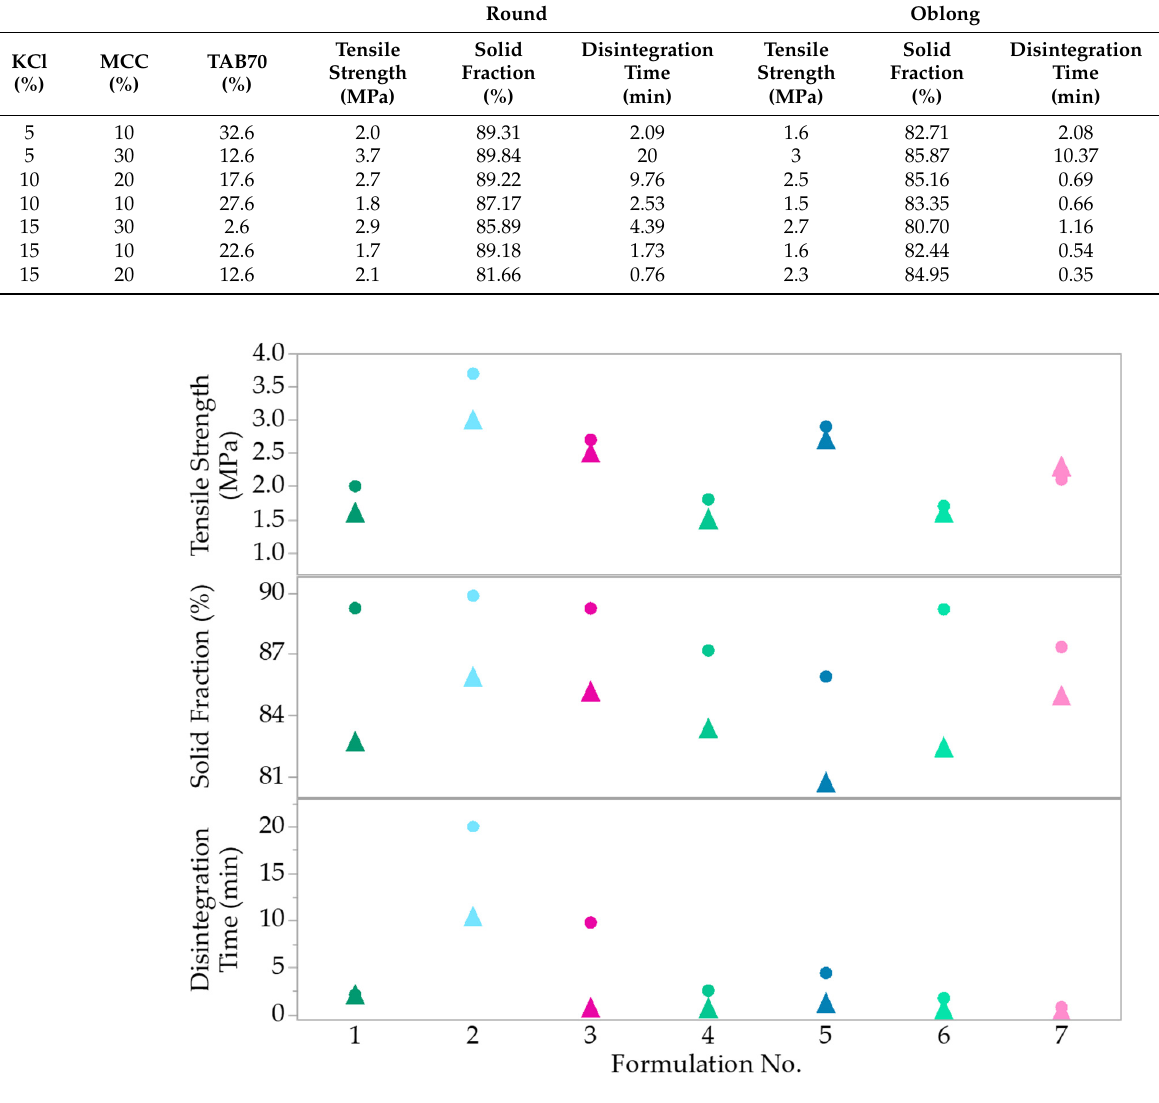
Figure 12. ITZ-KOL-ASD round (dots) and oblong (triangles) tablet formulations (F1 to F7) against CQAs measured.